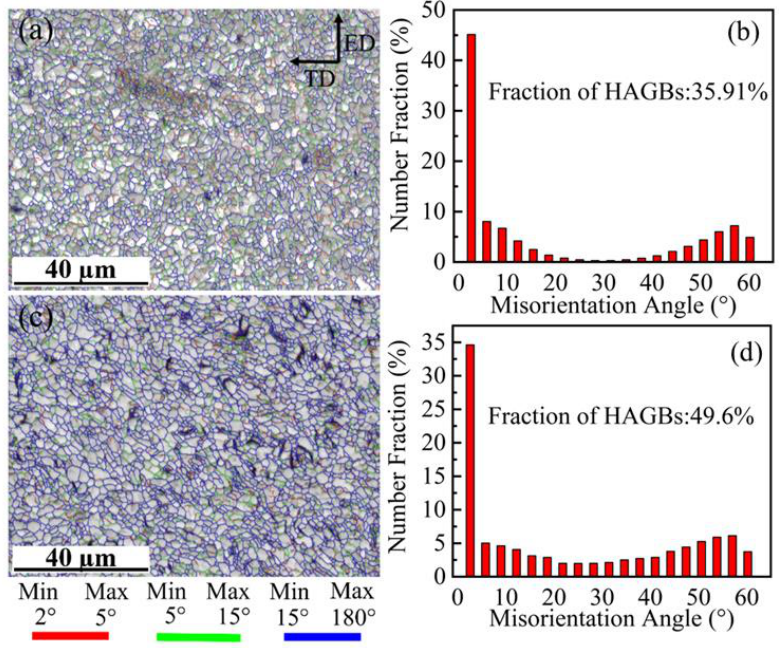
Figure 11. Misorientation angle diagram of the extruded composite: ( a , b ) welding zone; ( c , d ) matrix zone.